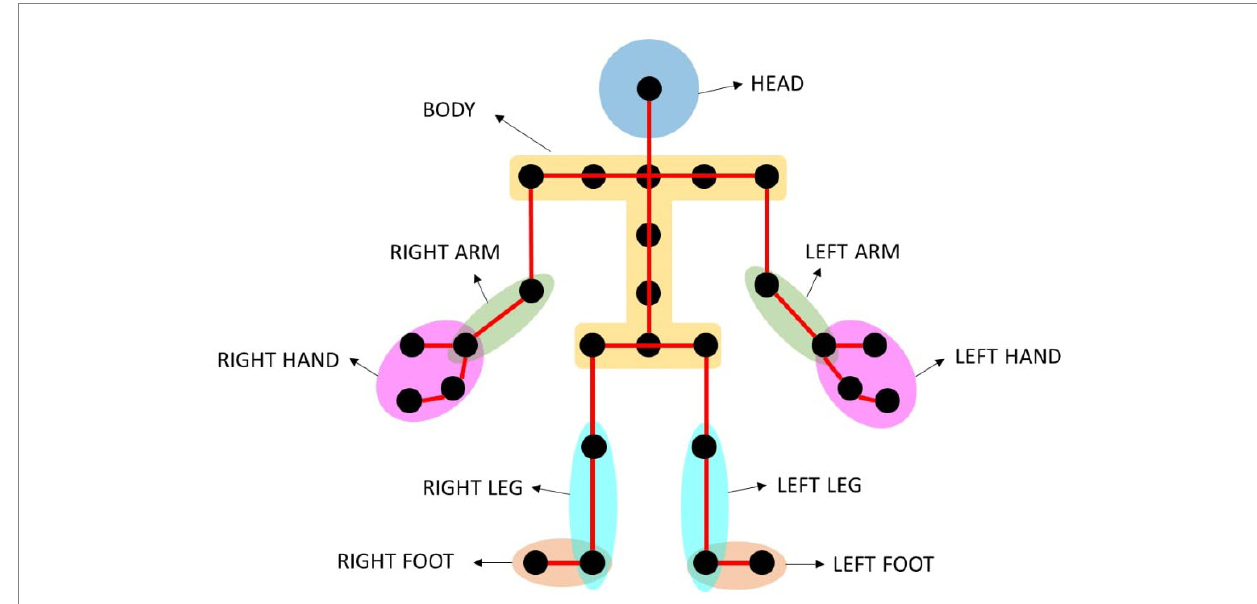
FIGURE 3 Body joints tracked by the Azure Kinect DK (black dots on the skeleton) and joint groups created (circled in different